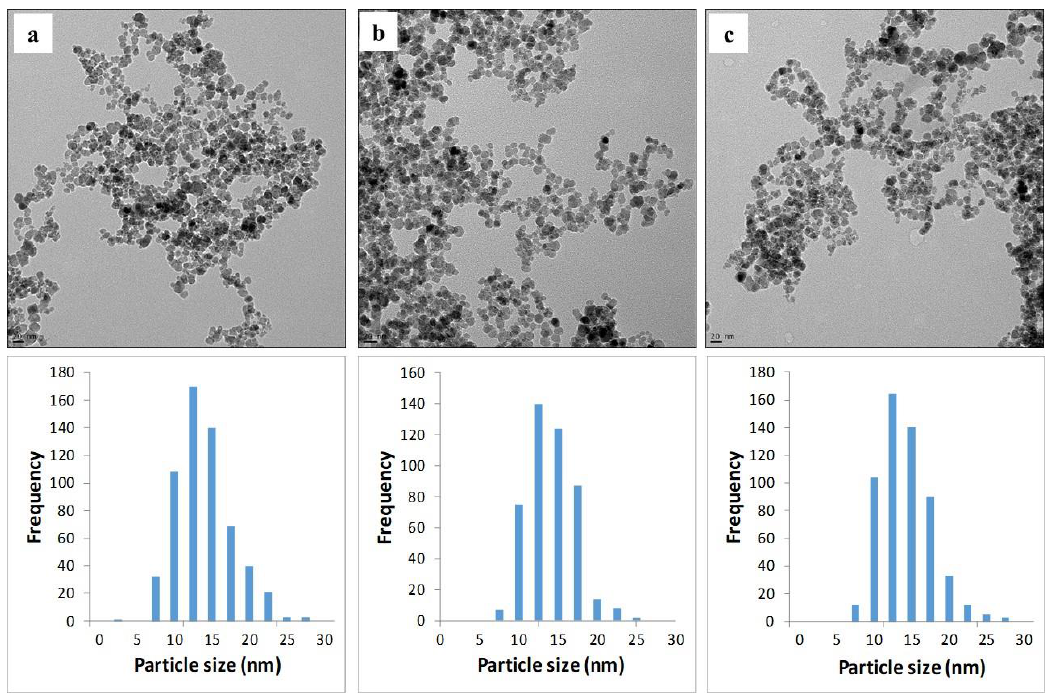
Figure 8. TEMs of nanoparticle (20 nm reference bar) synthesized from an iron salt solution (3.8 mM and 2:1 Fe 2+ :Fe 3+ ) with varying steady-state headspace concentrations of NH 3(g) , % v/v, (a) 1.6, (b) 3.3, and (c) 8.4. Table 1. Particle size analyses from transmission electron microscopy (TEMs) of syntheses from an iron salt solution (3.8 mM and 2:1 Figure 2. Fe 3 + ) with varying % v / v [NH 3(g) ] headspace. [NH 3(g) ], %v/v